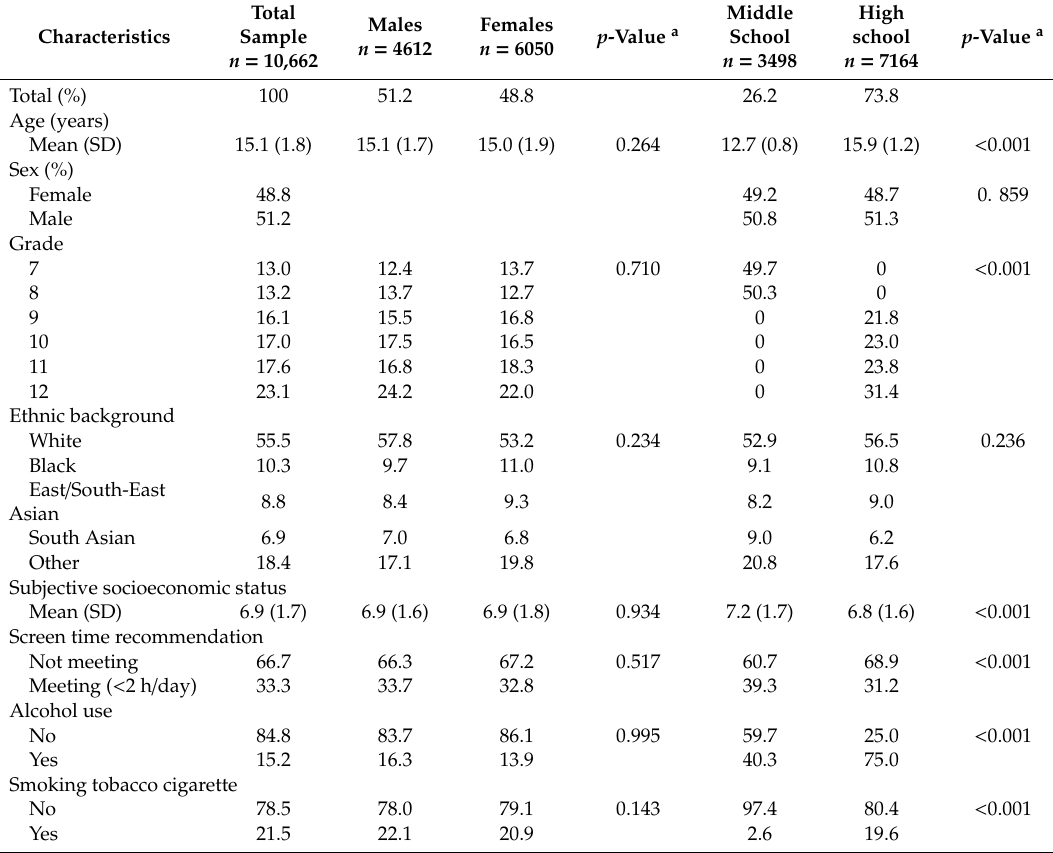
Table 1. Descriptive characteristics of the full sample and stratified by sex and grade